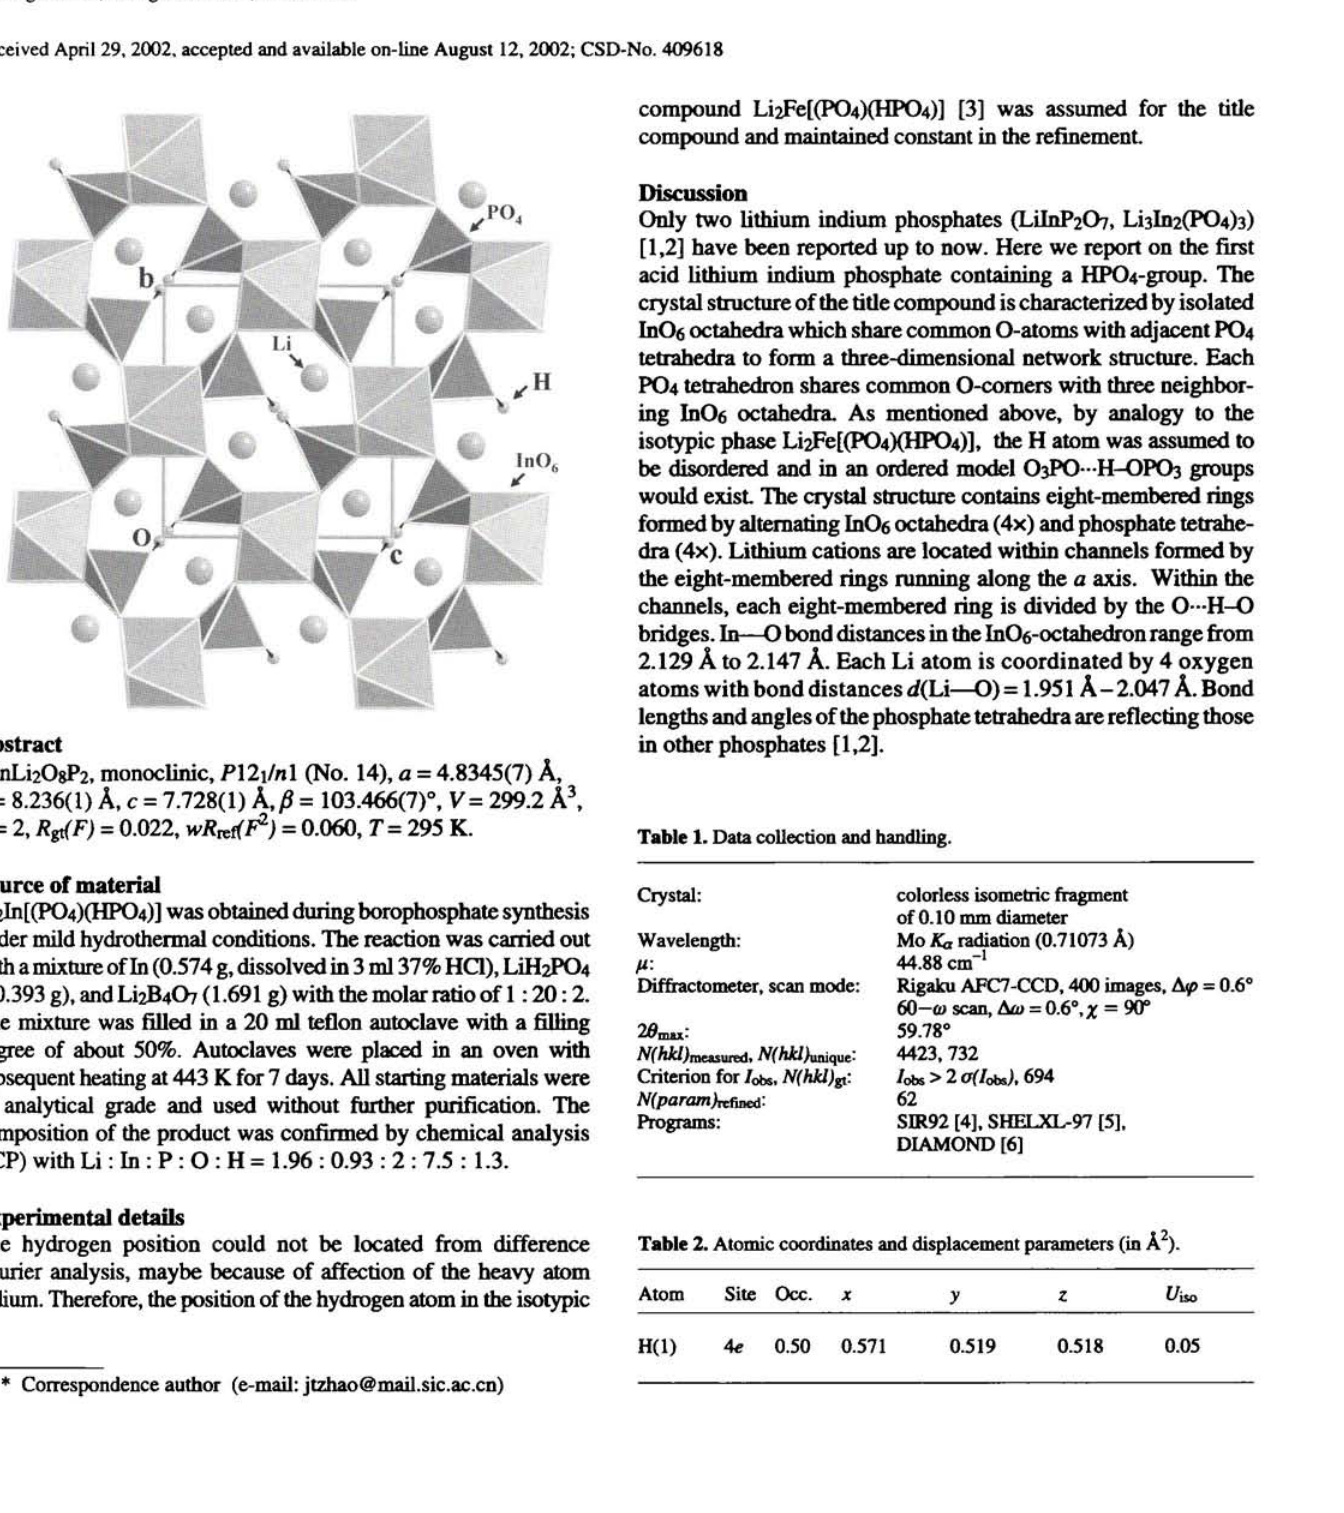
Table 2. Atomic coordinates and displacement parameters (in Â 2